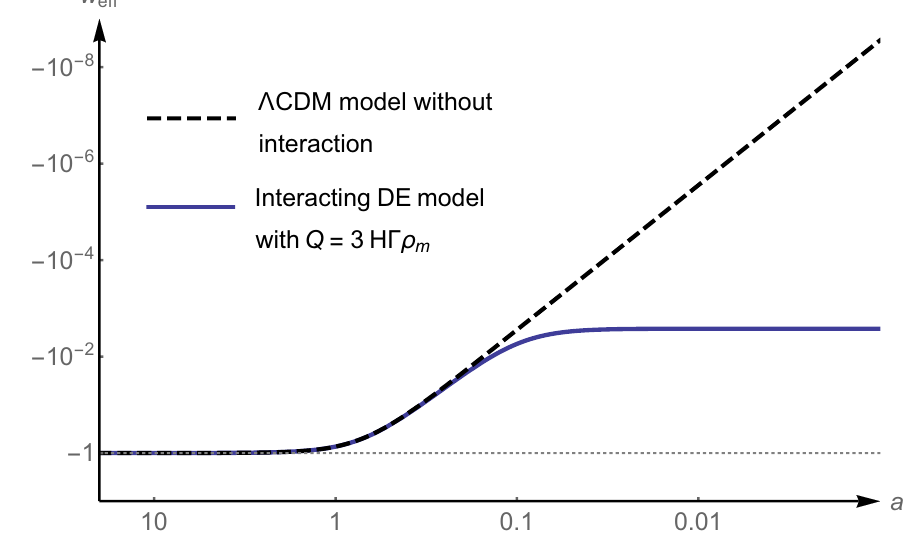
Figure 1. The evolution of the effective equation of state w eff in Λ CDM and interacting dark energy models. Note that time goes from left to right in this plot for a contracting universe. Here we set Γ = 0.0026 and w = − 1 for d